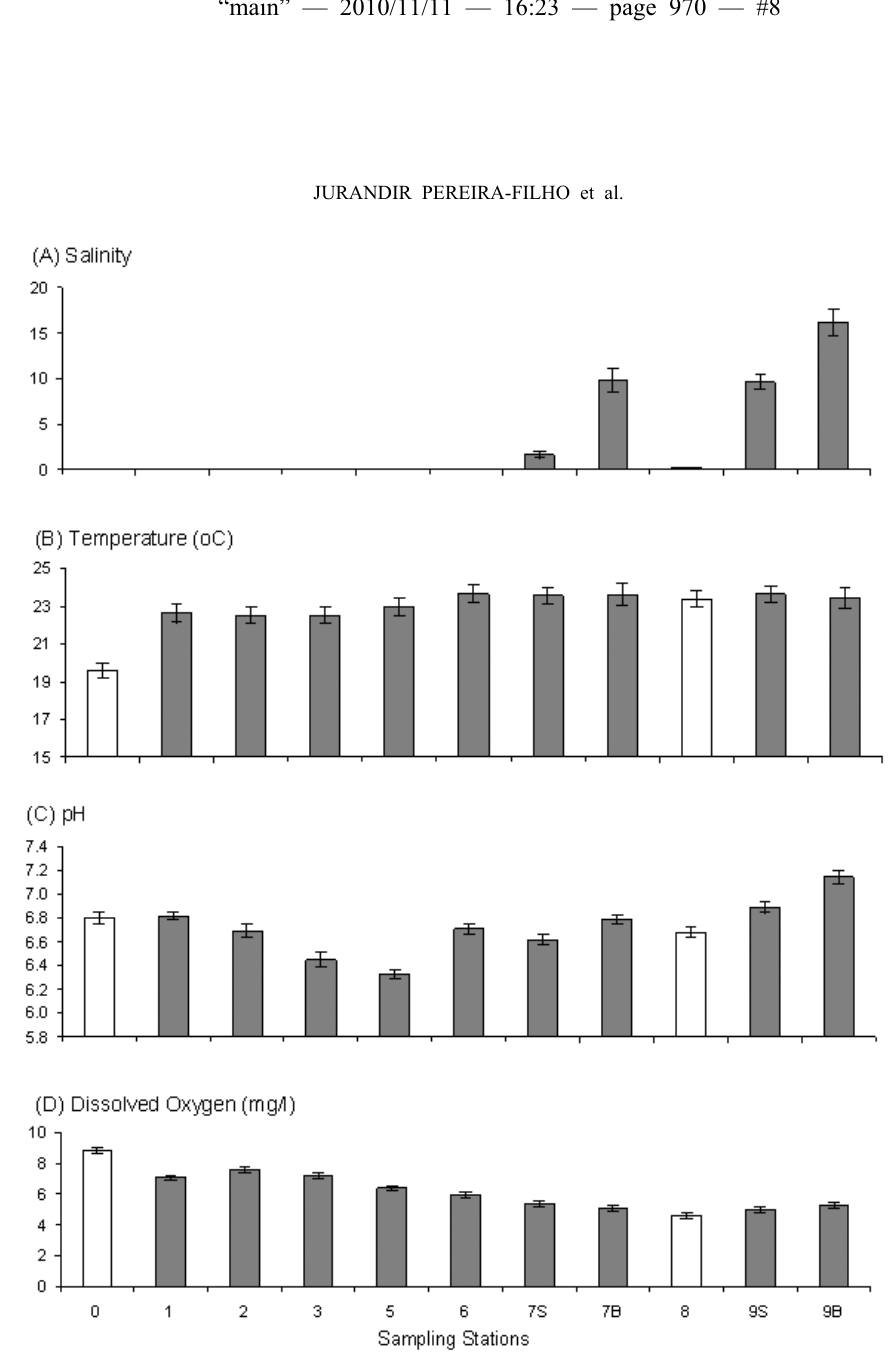
Fig. 2 – Spatial variation of (A) salinity, (B) temperature, (C) pH and (D) dissolved oxygen in the fluvial-estuarine system of the Itajaí-Açú River. Overall average and Standard Error for each sampling station, considering the entire period sampled (October 2003 to December 2004). The columns in gray represent the stations located in the estuary, and the others in the